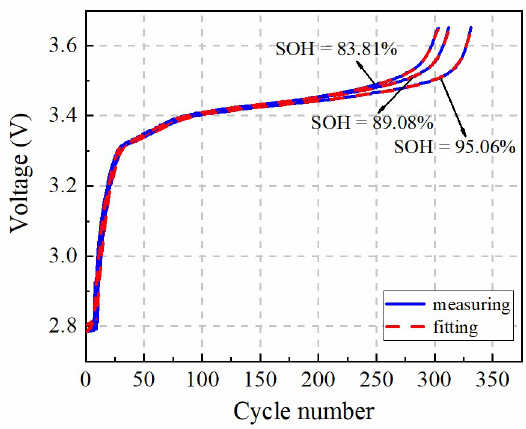
Figure 10. The validation of identification results of P D e and P C e .